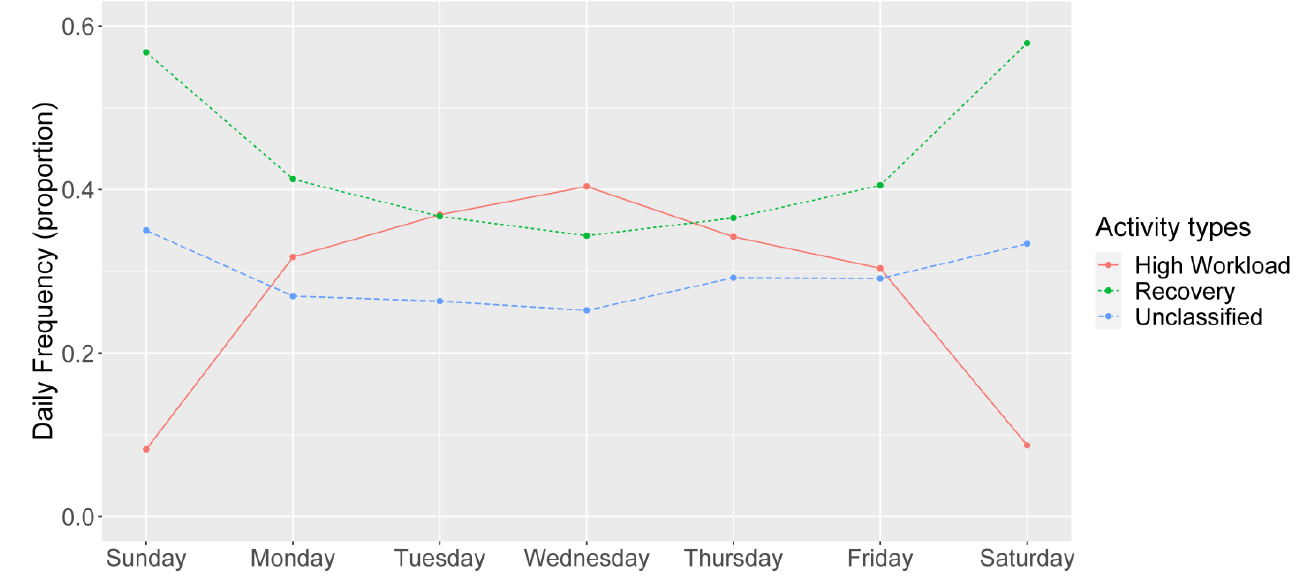
Figure 1. Distribution of activity frequencies, by day of week. Table 6. Day-of-week differences in activity frequencies. Values in parentheses represent 95% con- fidence intervals.